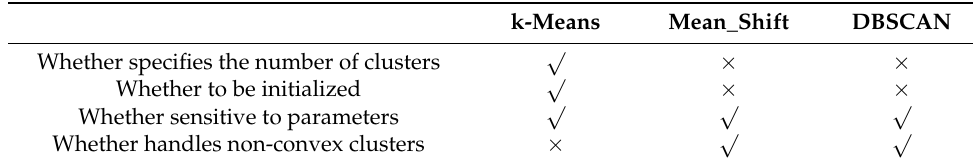
Table 2. Comparison of three clustering algorithms.